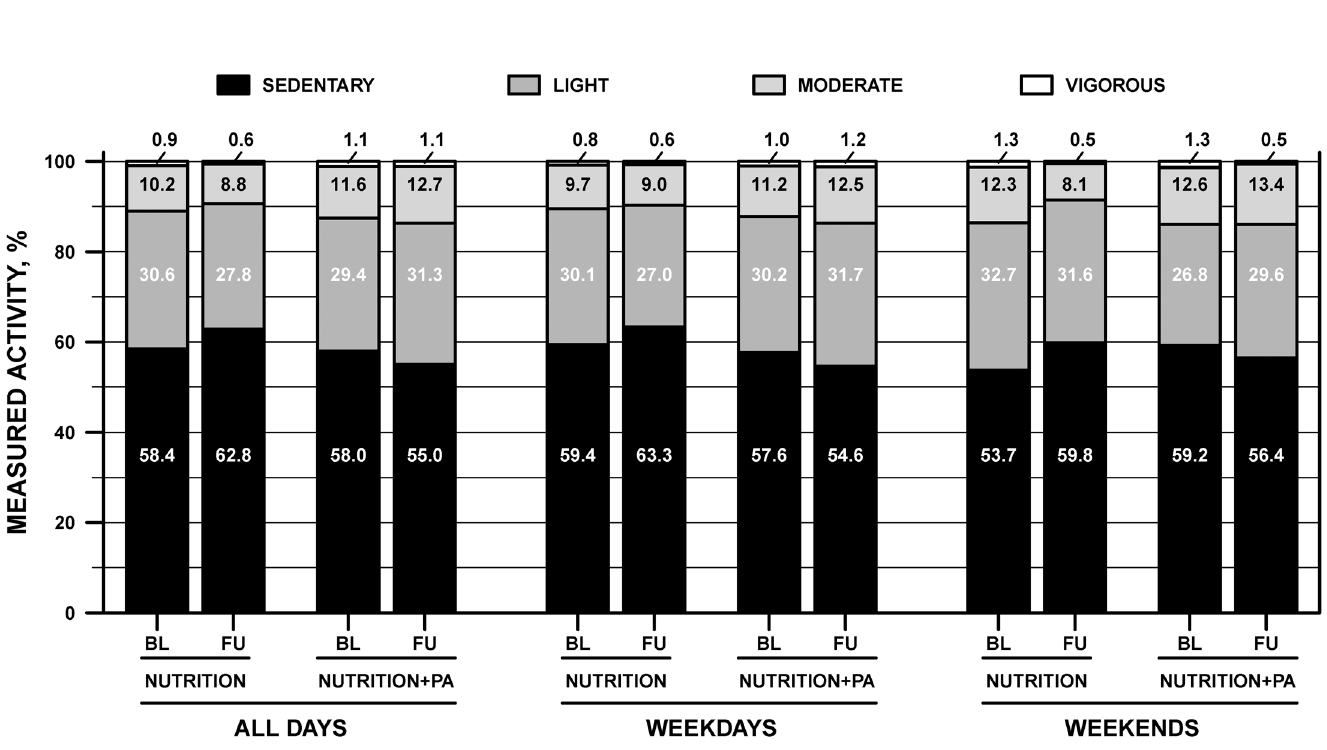
Fig 3. Proportion of time spent in sedentary behaviors and light, moderate, and vigorous physical activity (PA), as measured by accelerometry, at baseline (BL) and follow-up (FU) for the nutrition and nutrition+PA groups across all days, weekdays, and weekend